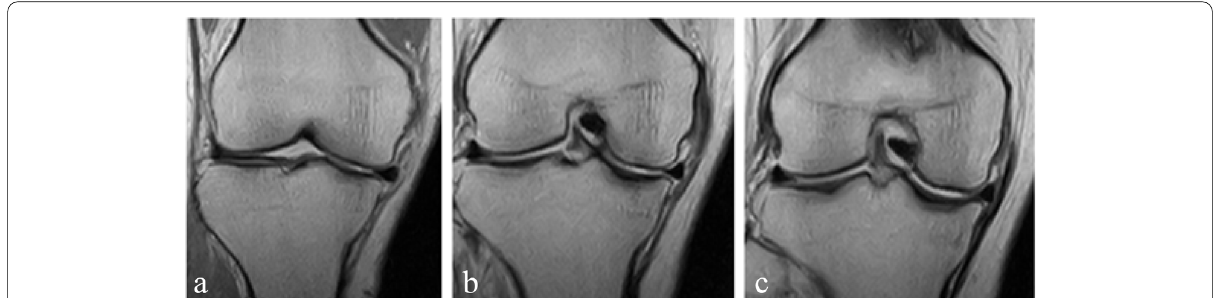
Fig. 2 Determination of the slice of medial 3 portions used for degeneration grading. a : Slice just anterior to the whole MCL image; b : Slice of the longest image of the MCL; c : Slice just posterior to the whole MCL